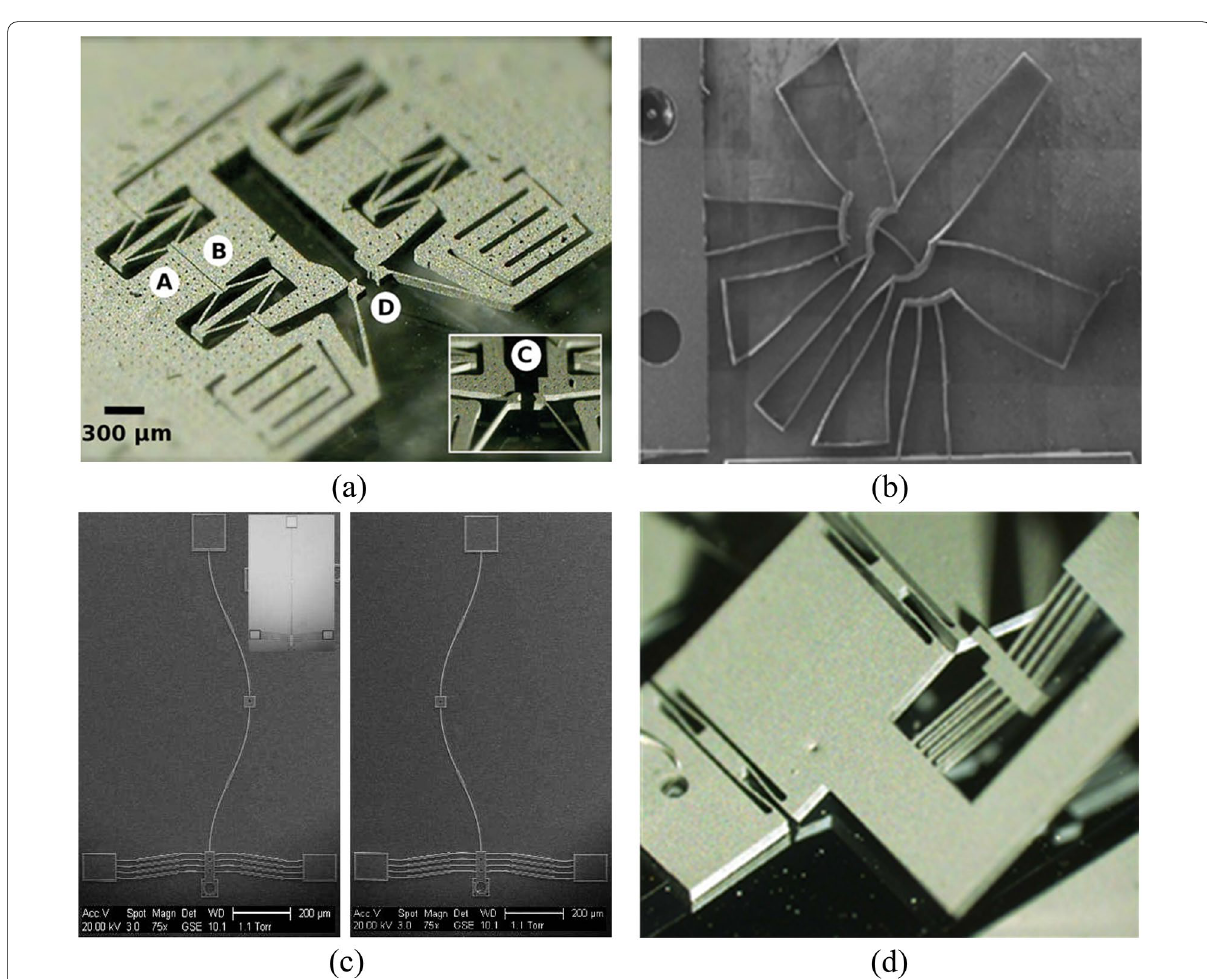
Figure 10 CMMs fabricated via CNT frameworking: ( a ) Micrograsper by Toone et al. [2] (©Taylor&Francis. Adapted by permission of Taylor&Francis. Permission to reuse must be obtained from the rightsholder), ( b ) Compliant rotational hinge by Fowler et al. [93] (©Elsevier. Adapted by permission of Elsevier. Permission to reuse must be obtained from the rightsholder), ( c ) Tristable mechanism by Chen et al. [94] (©ASME. Adapted by permission of ASME. Permission to reuse must be obtained from the rightsholder), ( d ) Lamina emergent mechanism by Fazio